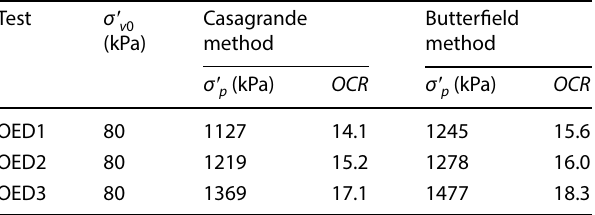
Table 3 Pre‑consolidation stress and OCR for samples from the Experimental Site tested on the high‑pressure oedometer test